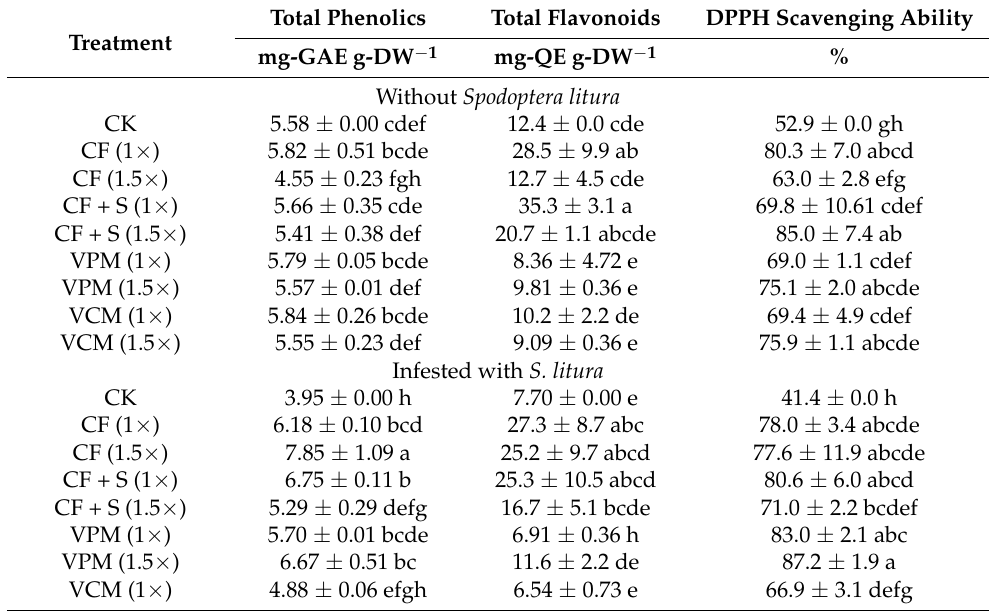
Table 5. The concentrations of total phenolics, total flavonoids, and DPPH scavenging ability in the leaves of Brassica chinensis grown in soils that received different treatments 1